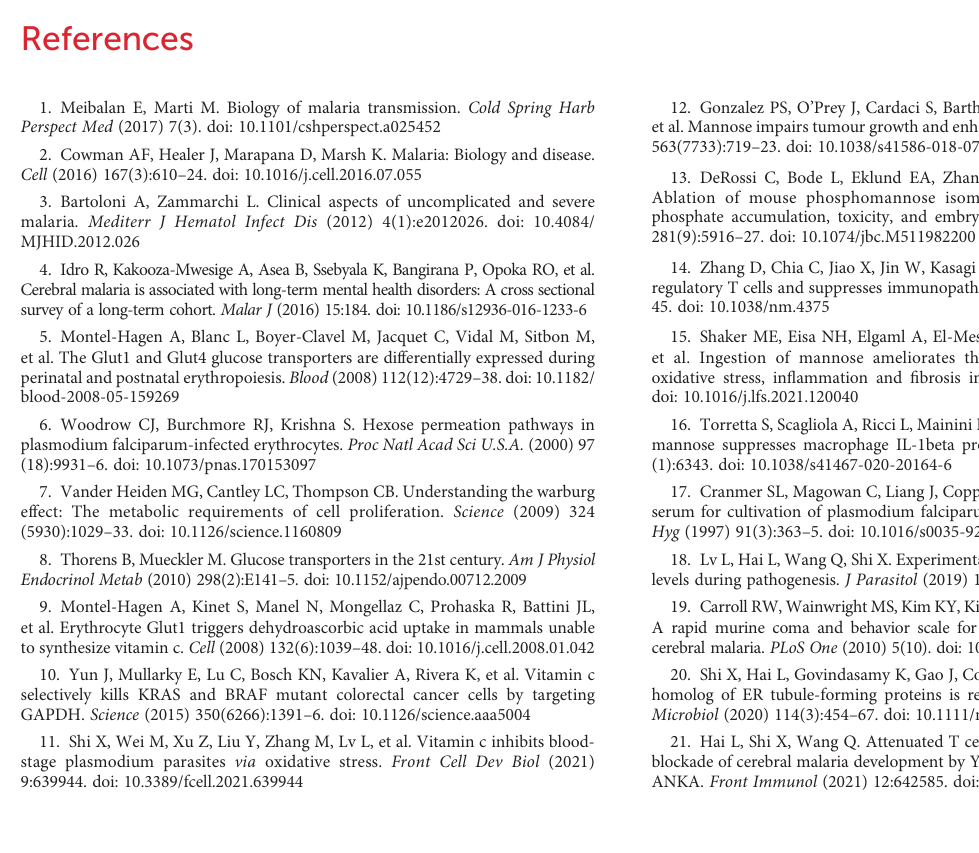
percentage of phagocytosing FITC + macrophages and MFI values are shown. Data are presented as mean ± SD. Analyses were carried out by one-way ANOVA followed by Tukey ’ s multiple comparison test. SUPPLEMENTARY FIGURE 5 Mannose treatment does not in fl uence the splenic macrophage population in P. berghei- infected BALB/c mice. (A) Parasitemia of P. berghei- infected BALB/c mice (n = 5/group). Two-way ANOVA with Tukey ’ s multiple comparisons test was used to analyze differences in parasitemia between thecontrol and mannose-treated groups. (B) Spleen weight in BALB/c mice (n = 5/group) 4 and 7 days post-infection (p.i.). The weights of spleens harvested from uninfected mice (n = 5/group) are shown as blank controls. (C) Representative fl ow cytometry dot plots of F4/80 + CD11b + macrophages in CD45 + splenocytes from BALB/c mice 4 days p.i. (n = 5/group) and the uninfected mice (n = 5/group). (D) The frequency and number of splenic macrophages in (C) . (E) Representative fl ow cytometry dot plots of F4/80 + CD11b + macrophages in CD45 + splenocytes from BALB/c mice 7 days p.i. (n = 5/group) and the uninfected mice (n = 5/group). (F) The frequency and number of splenic macrophages in (E) . Data are presented as mean ± SD. Analyses were carried out by one-way ANOVA followed by Tukey ’ s multiple comparison test. SUPPLEMENTARY FIGURE 6 Mannose treatment suppresses T-cell migration into the brain. (A, B) Representative fl ow cytometry dot plots for showing the CD4 + T cells (A) and CD8 + T cells (B) in peripheral blood mononuclear cells from uninfected and infected C57BL/6 mice 7 days p.i. (C, D) Representative fl ow cytometry dot plots for showing the CD4 + T cells (C) and CD8 + T cells (D) inbrainmononuclearcellsfromuninfectedandinfectedC57BL/6 mice 7 days p.i. (E, F) Treatment with mannose signi fi cantly decreased IFN- g andTNF- a mRNAexpression inthebrainsof infectedC57BL/6mice 7 days p.i. (n =